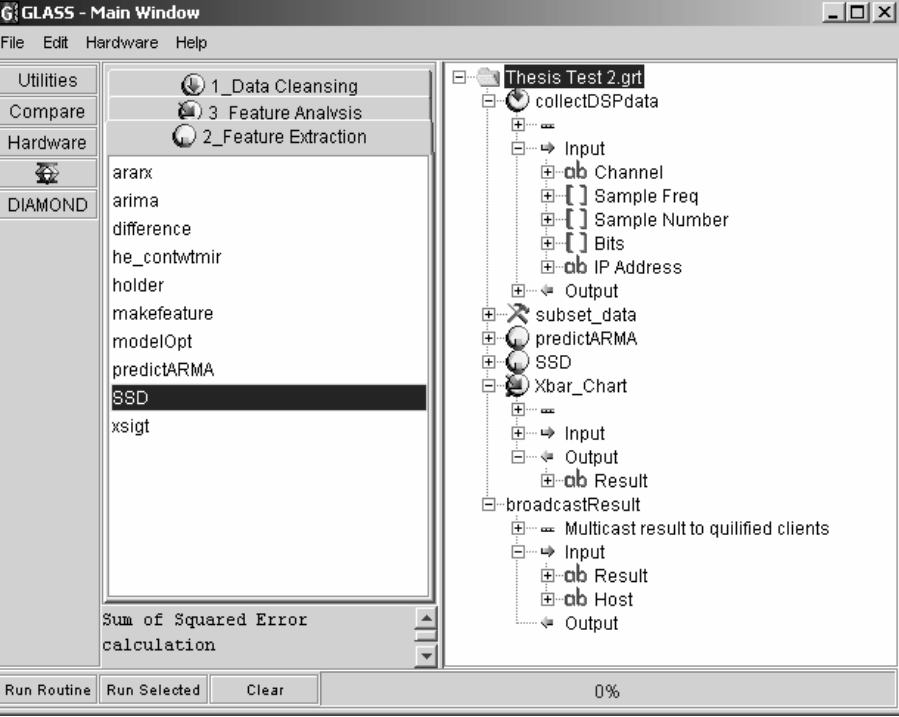
Fig. 1. The GLASS GUI showing an algorithm assembled for performing a sequential probability ration test on features extracted from data obtained on a laboratory frame structure. Functions can be re-ordered or inserted at anytime. Functions are then linked by their input and output variables in a cascading